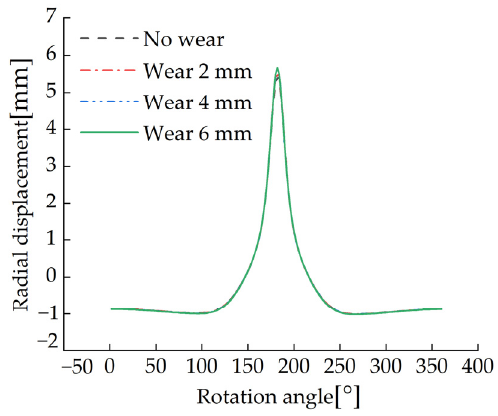
World Electr. Veh. J. 2022 , 13 , x FOR PEER REVIEW Figure 23. Contact pressure distribution of tire longitudinal contact patch under different wear. Figure 23. Contact pressure distribution of tire longitudinal contact patch under different wear. Figure 23. Contact pressure distribution of tire longitudinal contact patch under different wear.